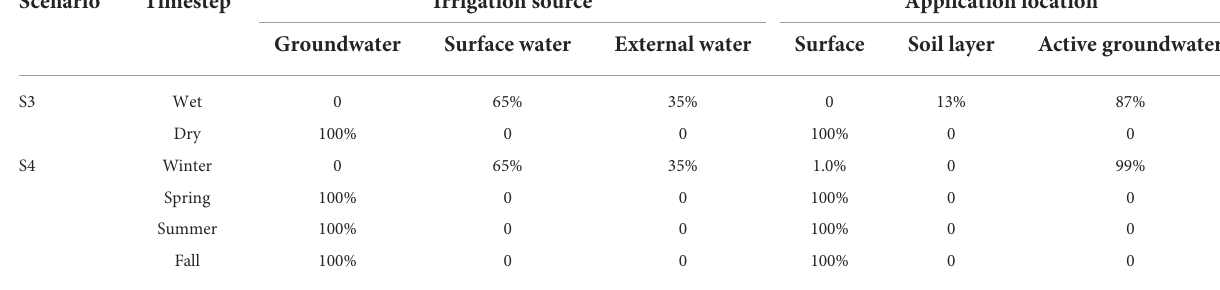
TABLE 4 Source and application location of irrigation water during each